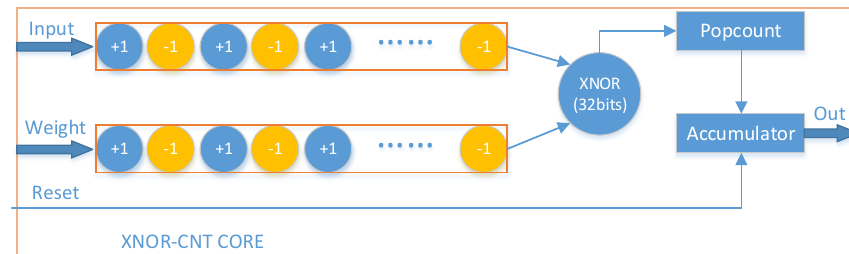
Figure 6. Hardware diagram of the XNOR-CNT ROW which conducts an XNOR-popcount operation.